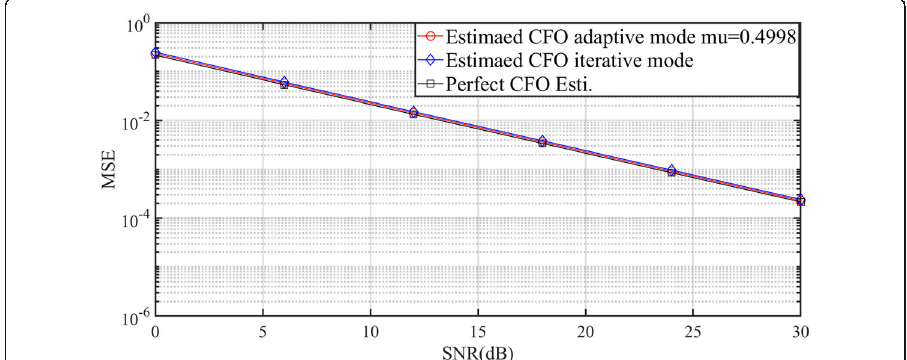
Fig. 13 The MSE performance for channel estimation in the adaptive mode at v = 60